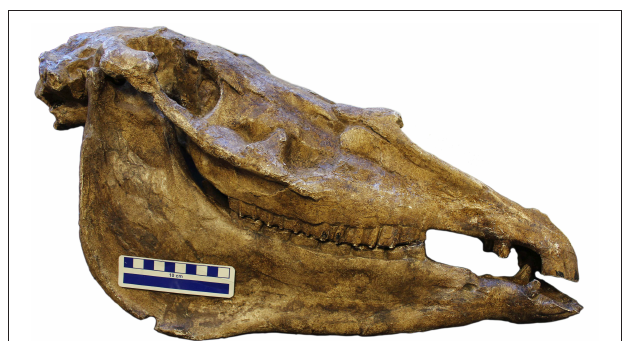
FIGURE 3 | Right lateral view of cast of holotype skull with mandible of E. stenonis , NHMUK PV M 29511.